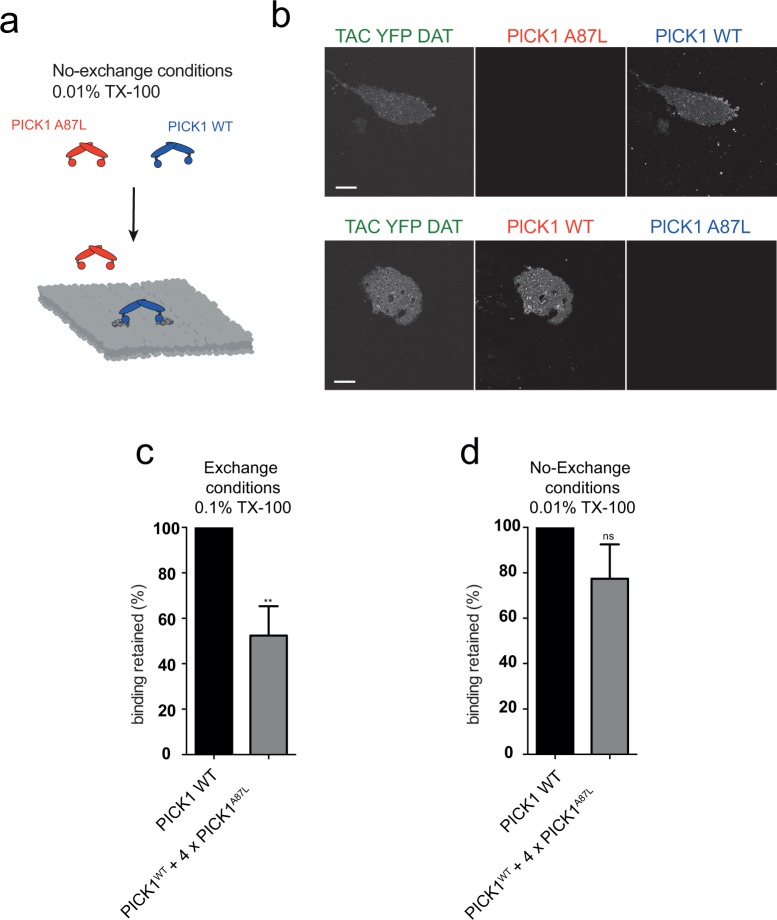
PICK1 WT binding does not promote nucleation of PDZ independent binding on the membrane sheets.(a) Schematic representation of the nucleation experiment where PICK1 A87L/A87L and PICK1 WT/WT are mixed under no-exchange conditions (0.01% TX-100) (b) Representative images of the 0.01% exchange. Bound PICK1 WT/WT does not facilitate binding of PICK1 A87L/A87L through oligomerization. Color labeling reversed in bottom row. (c–d) Binding of PICK1 WT after incubation with four times excess PICK1 A87L in exchange (0.1%TX-100) or no-exchange (0.01% TX-100) conditions at a fixed PICK1 WT concentration of 100 nM. As expected, Bmax is maintained (p=0.0611) under no-exchange conditions. Under exchange conditions the Bmax was reduced to 52 ± 10% (**p≤0.01).